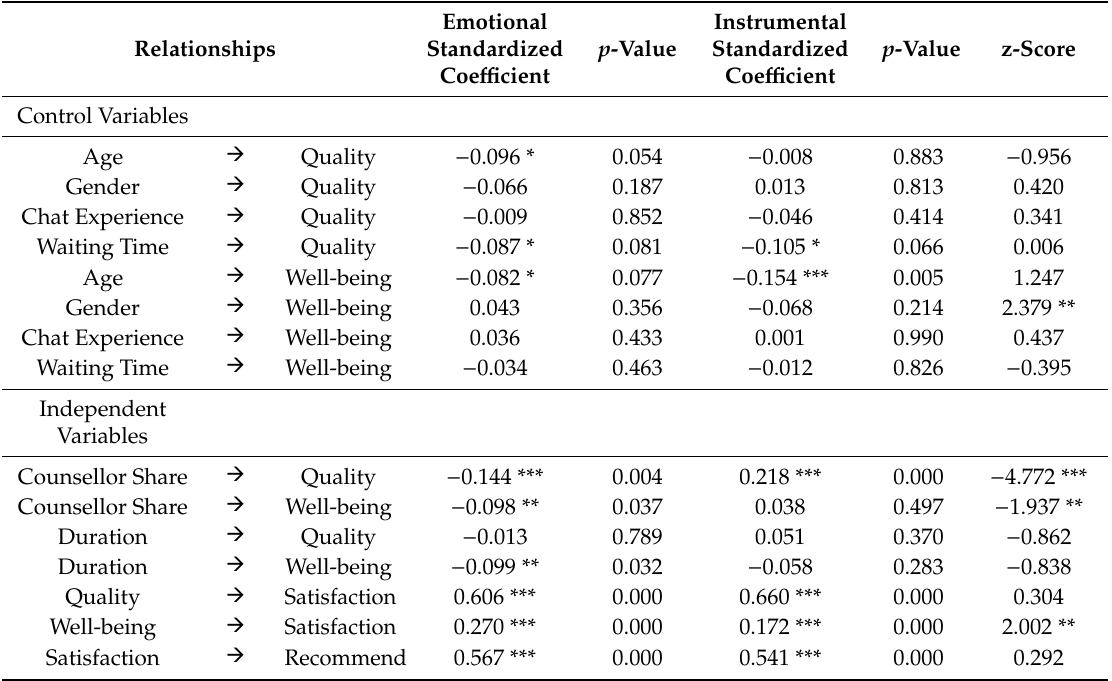
Table 3. Summary of results for emotional and instrumental support chats.